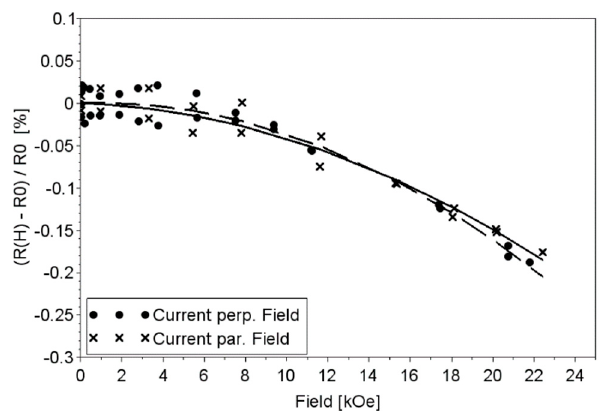
Figure 10. Drop in room-temperature resistance as a function of applied magnetic fields for HPT-deformed Cu 85 Fe 15 . The continuous line (parallel alignment) and dashed line (perpendicular alignment) are derived from polynomial fits and serve only as a guide for the eye.